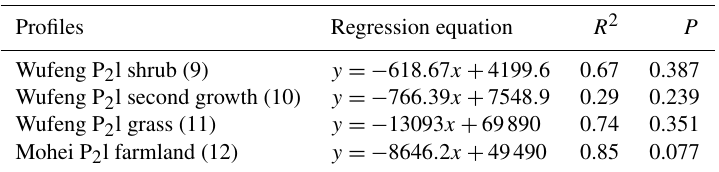
Table 2. Correlation analysis of soil CO 2 and soil organic carbon in shale areas of karst.